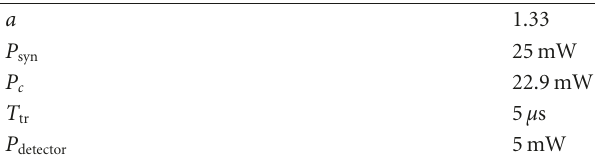
Table 1: Typical values of energy model parameters.